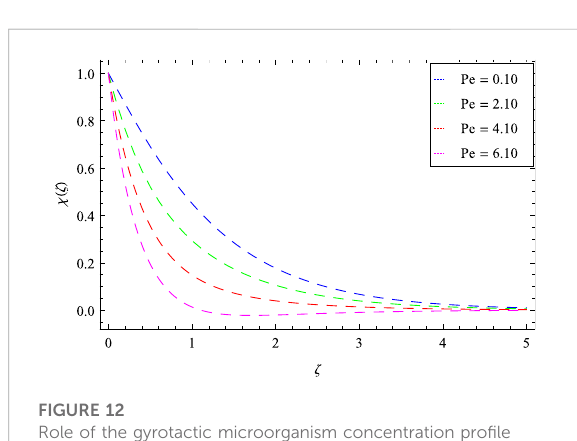
FIGURE 11 Role of the gyrotactic microorganism concentration pro fi le and parameter.